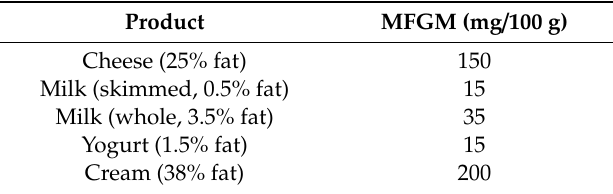
Table 1. Comparison of milk fat globule membrane (MFGM) content in di ff erent dairy products. Data are from Dewettinck et al., 2011, and Conway et al., 2014